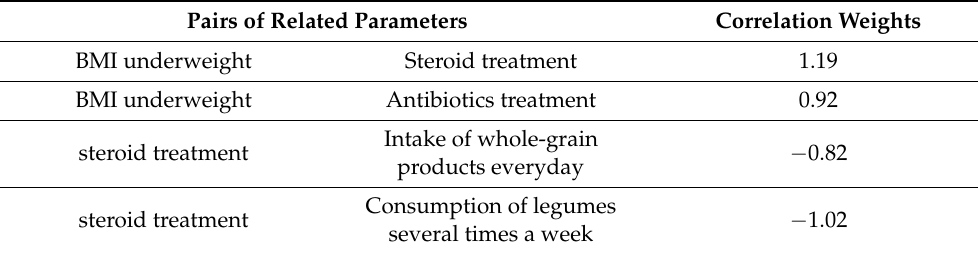
Table 4. Association weights for BMI category or steroid treatment and consumptions of various plant products or antibiotics treatment, based on the correspondence analysis model (BMI underweight— BMI < 18.5 kg/m 2